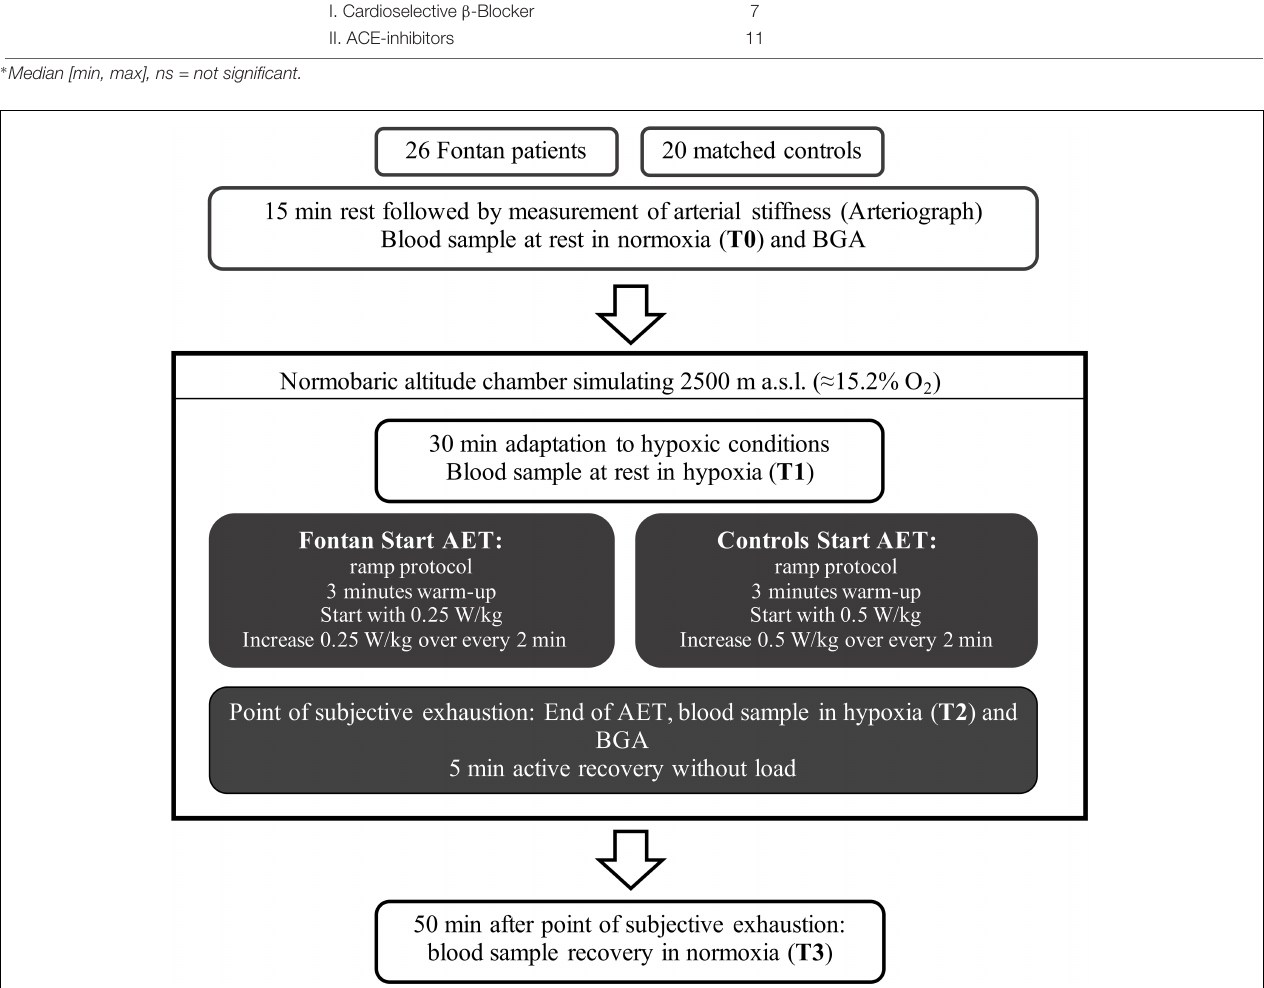
FIGURE 1 | Study protocol. asl = above sea level, AET = acute exercise testing, BGA = blood gas analysis.